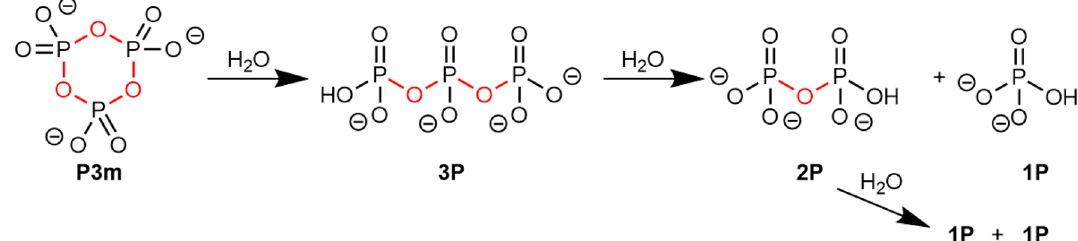
Scheme 5. The NHP (natural hydrolysis products) of trimetaphosphate. High free energy P–O–P bonds are outlined in